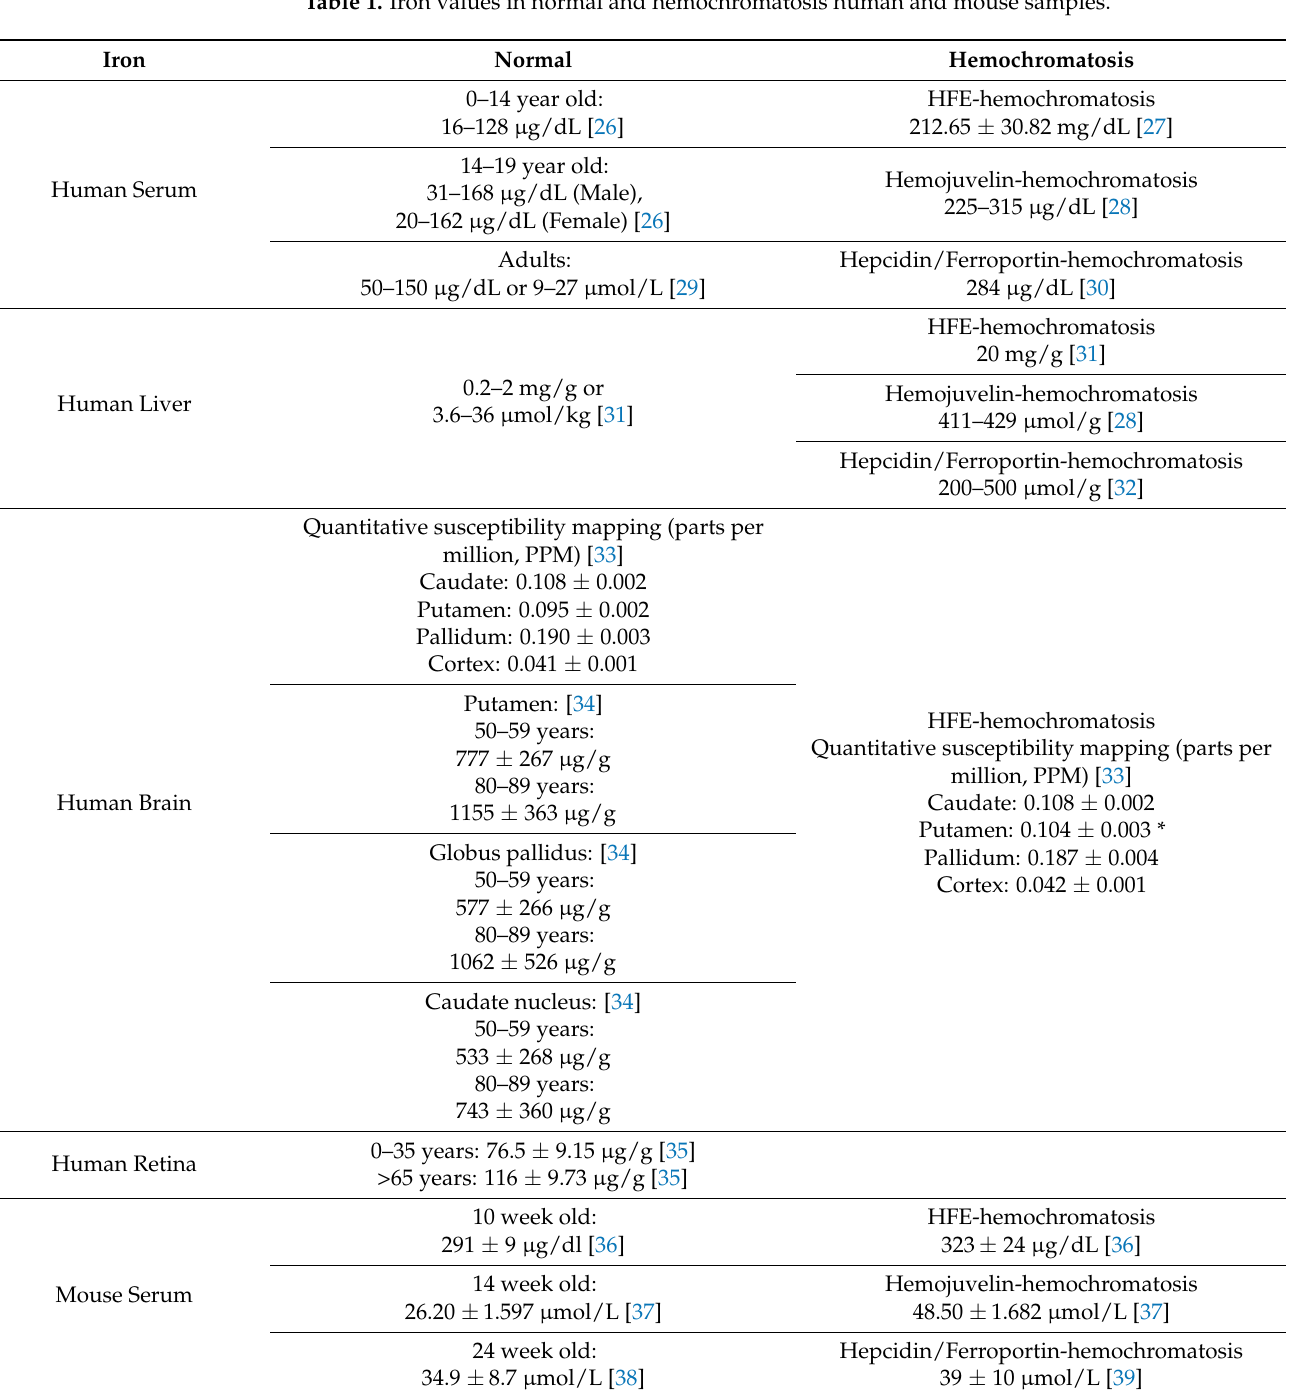
Table 1. Iron values in normal and hemochromatosis human and mouse